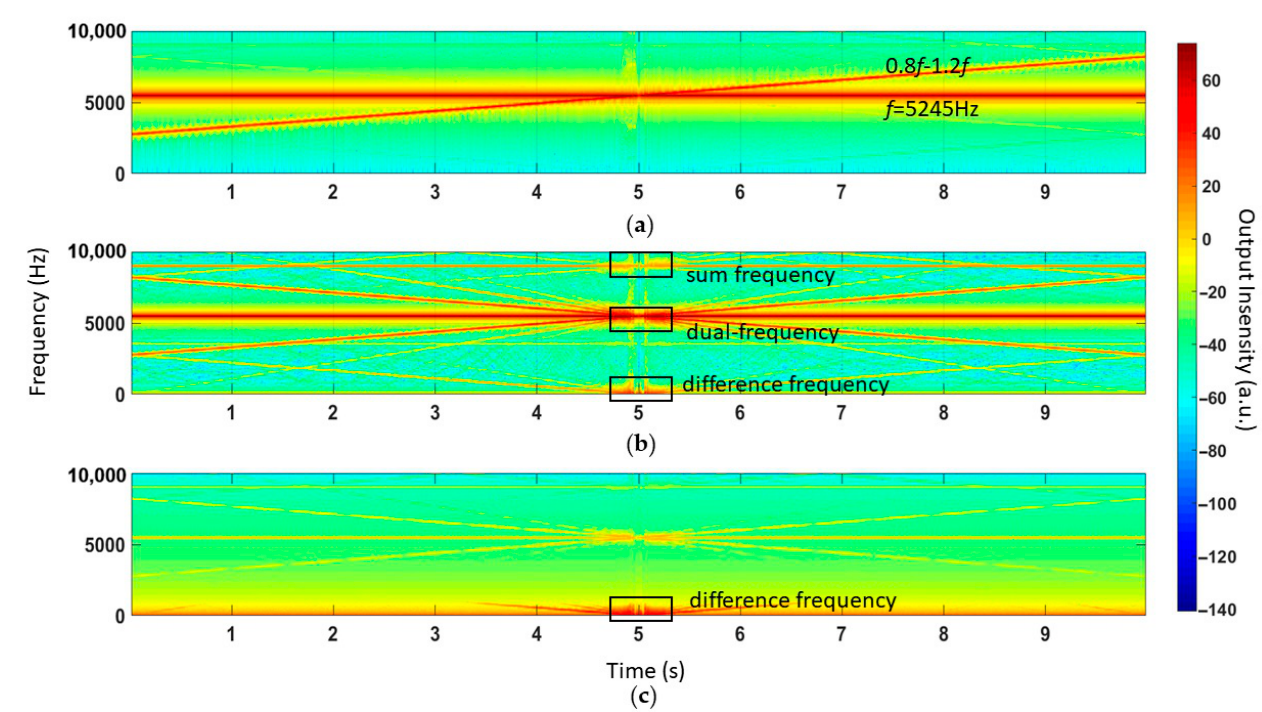
Figure 9. ( a ) Injecting dual frequency acoustic attack, an acoustic signal with fixed frequency and an acoustic signal with sweeping frequency. ( b ) The nonlinear effect leads to the generation of sum frequency signals and difference frequency signals. ( c ) Low-pass filtering only preserves the difference frequency signal.